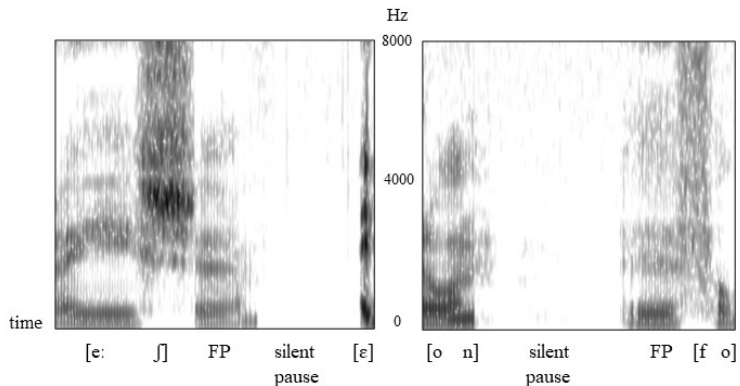
Figure 1. Speech fragments where FP is followed ( left ) and preceded ( right ) by a silent pause and is attached to the last consonant [ ʃ ] of the preceding word és ‘and’ ( left ) and to the first consonant [ f ] of the following word fogunk ‘/we/will’ ( right ).